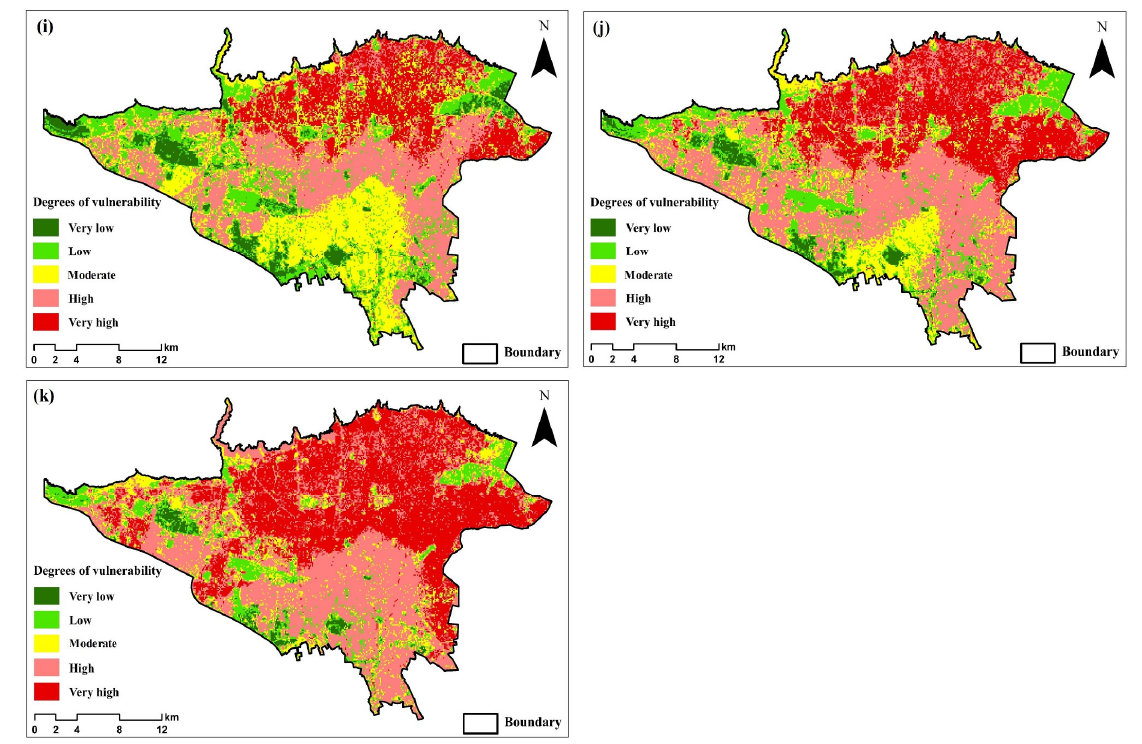
Figure 6. Flood vulnerability map ( a ) ORness = 0; ( b ) ORness = 0.1; ( c ) ORness = 0.2; ( d ) ORness = 0.3; ( e ) ORness = 0.4; ( f ) ORness = 0.5; ( g ) ORness = 0.6; ( h ) ORness = 0.7; ( i ) ORness = 0.8; ( j ) ORness = 0.9; ( k ) ORness = 1.